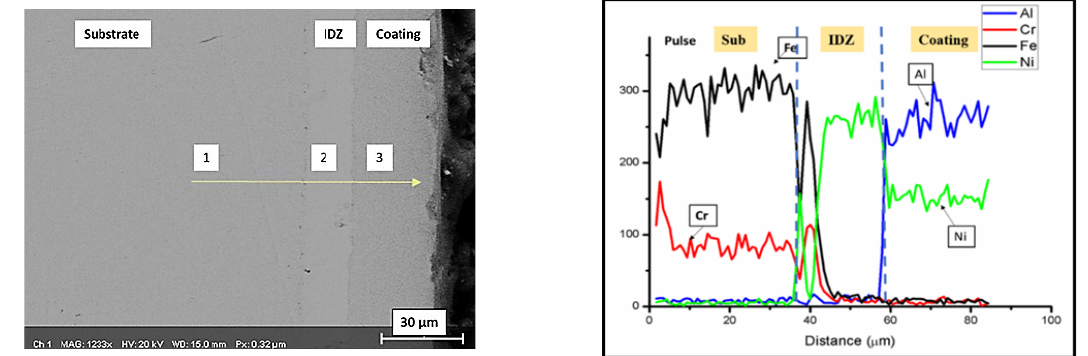
Figure 4. The SEM micrograph of the coating cross-section ( left ) along with corresponding line scan of the same ( right ).